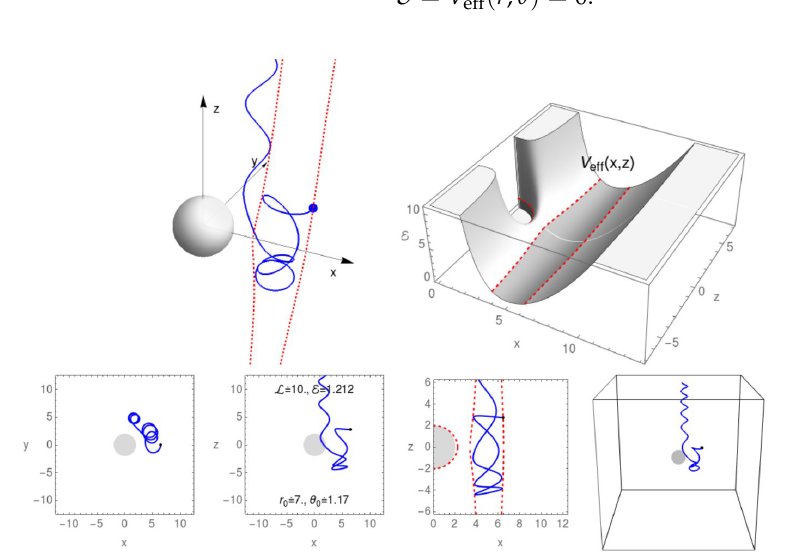
Figure 3. Effective potential of the charged particle motion and an example of the chaotic type of the particle